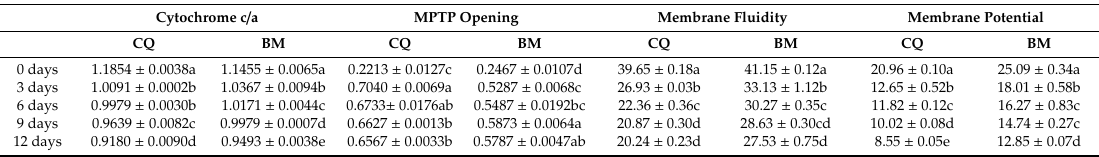
Table 3. E ff ect of Ca(NO 3 ) 2 stress on Cytochrome c / a, MPTP opening, membrane fluidity, and membrane potential in cucumber root mitochondria. The p values marked with similar letters are not significantly di ff erent (DMRT, p < 0.05). All the values are the mean of three replicates ± SD.